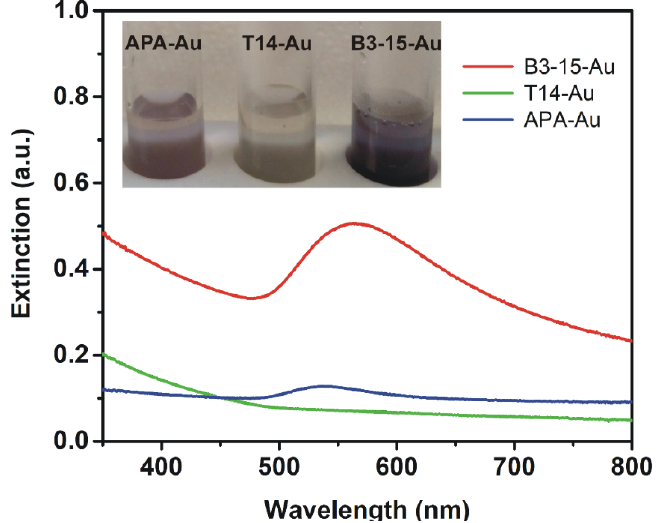
Figure 1. Extinction spectra of EPS B3-15-Au NPs (red), EPS T14-Au NPs (green), and γ -PGA-APA-Au NPs (blue) together with photographs of the three samples.